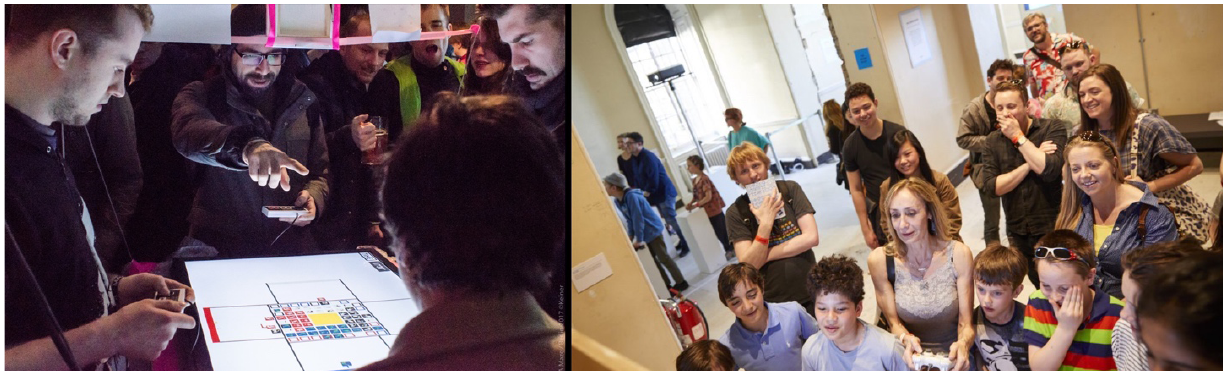
Figure 1. Many events design spaces which allow play and spectatorship to co-exist, supporting ecologies of participa- tion. These include A MAZE. / Berlin, left showcasing SIHEYU4N (We Are Müesli & Koning, 2015). Image copyright by Jens Keiner (2017, reprinted with permission). Right showcasing Now Play This. Image copyright by Ben Peter Catchpole (2017, reprinted with permission). Games Are for Everyone and A MAZE. /